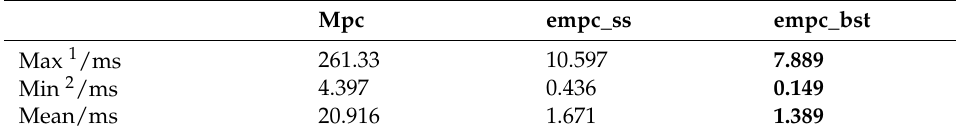
Table 3. Statistical characteristics of calculated time consumption in each